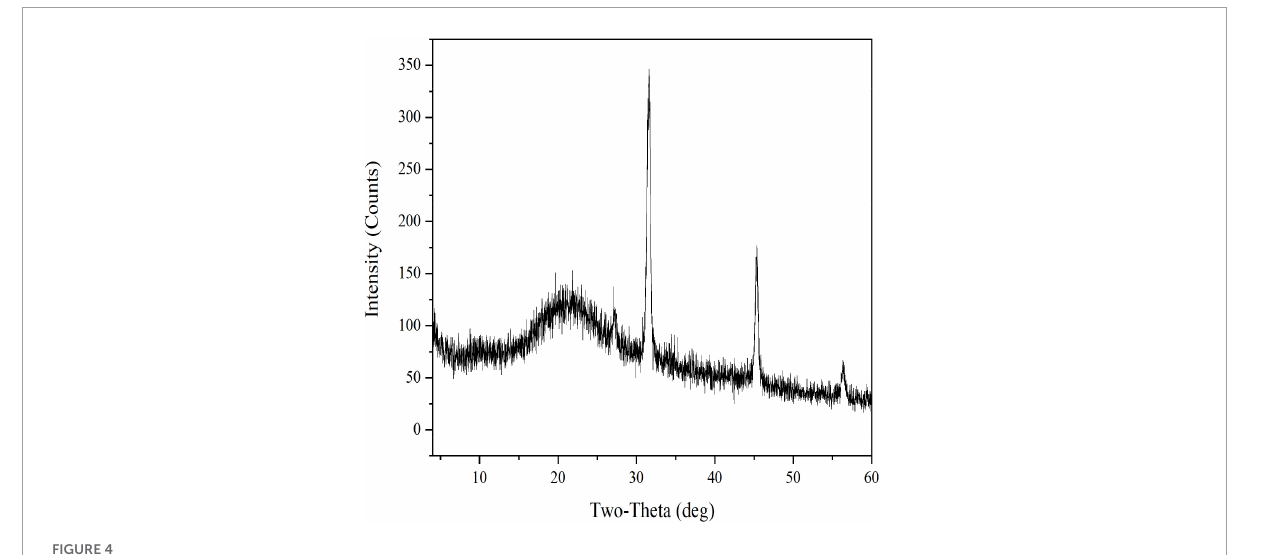
FIGURE4 X-ray diffraction curve of